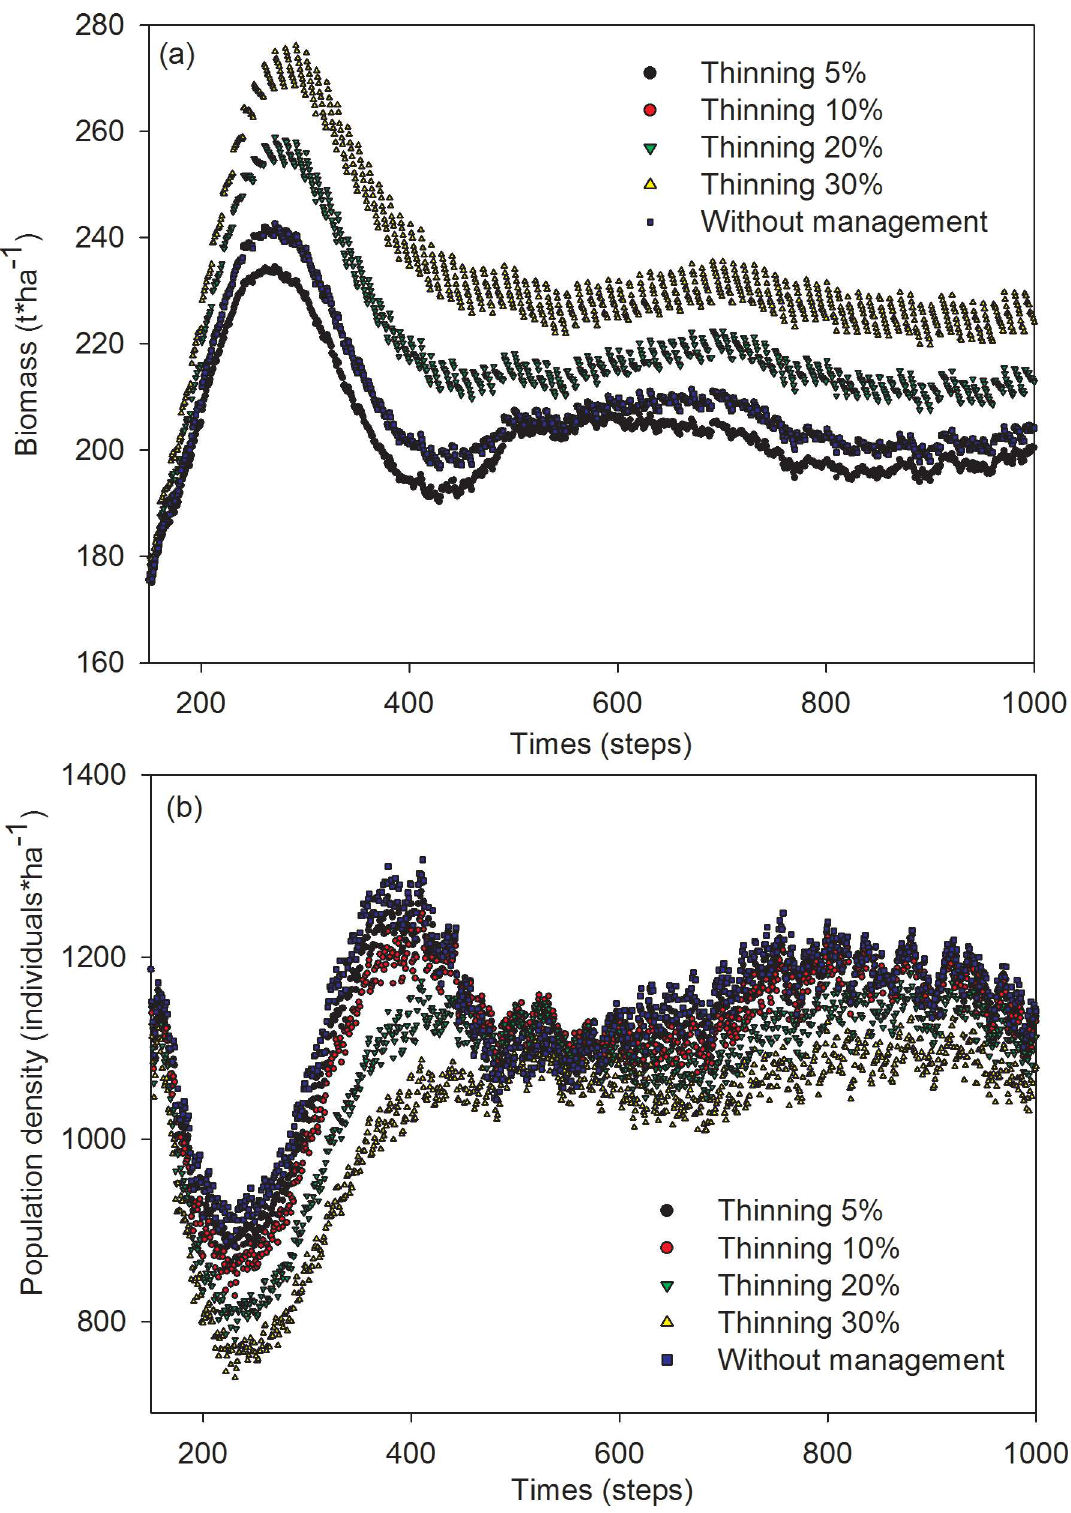
Fig 4. Simulation results of the effects of thinning on biomass (a) and populationdensity (b) of mature trees in Mongolian pine